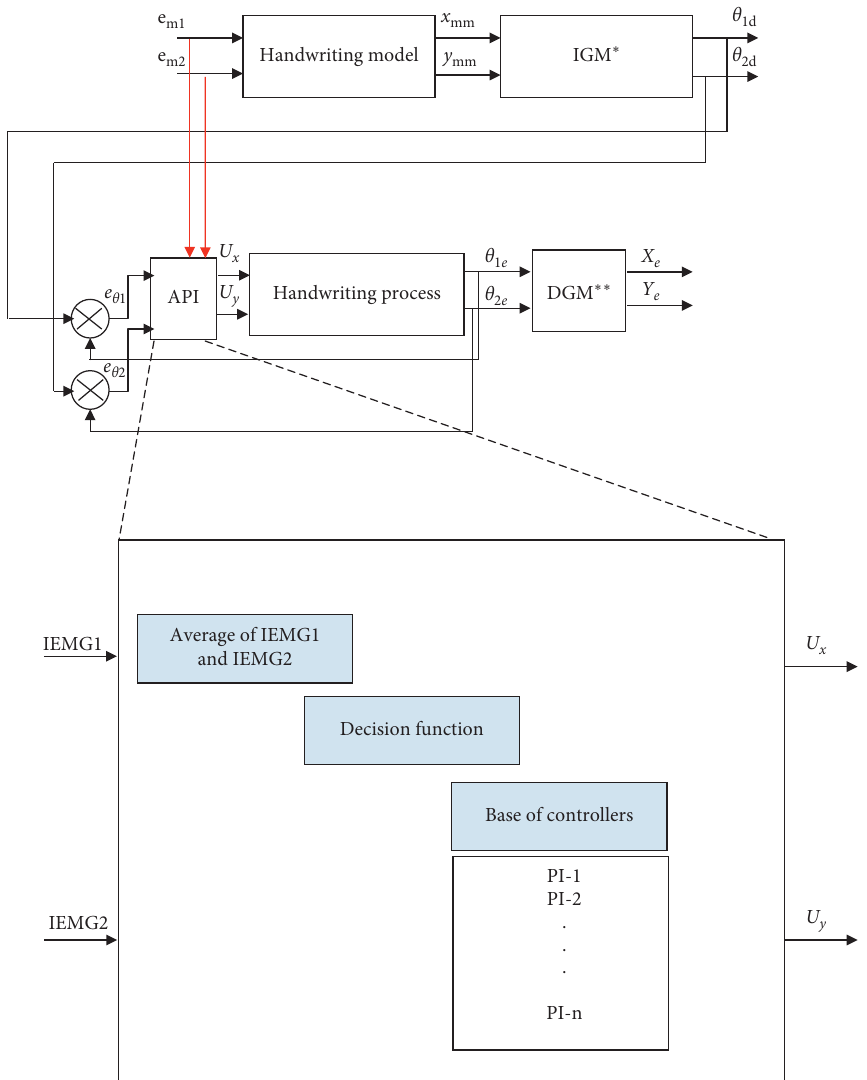
Figure 12: Principle of the adaptive control approach. ∗ Direct geometric model. ∗∗ Inverse geometric